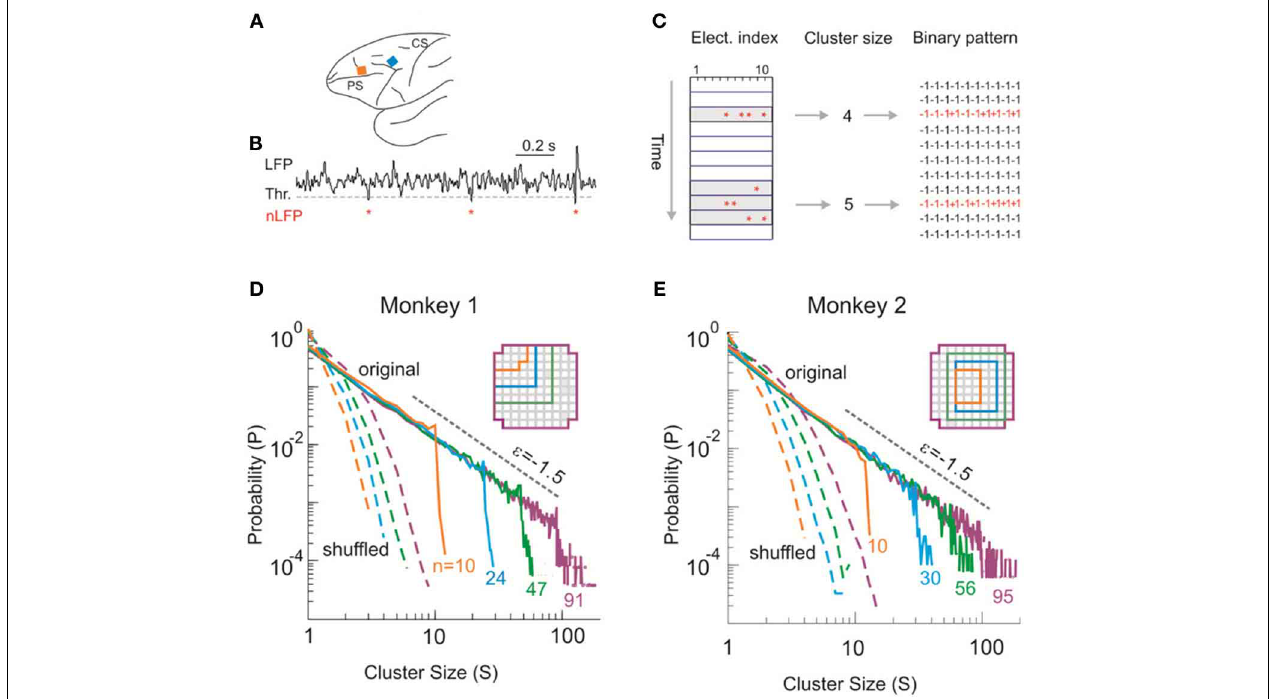
FIGURE 1 | Identifying avalanche dynamics in LFP signals. (A) Lateral view of the macaque brain showing the position of the multi-electrode array (square, not to scale) in pre-motor (Monkey 1; blue) and prefrontal (Monkey 2; orange) cortex. PS, Principal Sulcus; CS, Central Sulcus. (B) Example period of continuous LFP at a single electrode. Asterisks indicate peaks of negative deflections in the LFP (nLFPs) that pass the threshold (Thr., broken line; − 2.5SD). (C) Identification of spatiotemporal nLFP clusters and corresponding spatial patterns. Left: nLFPs that occur in the same time bin or consecutive bins of length (cid:2) t define a spatiotemporal cluster, whose size is